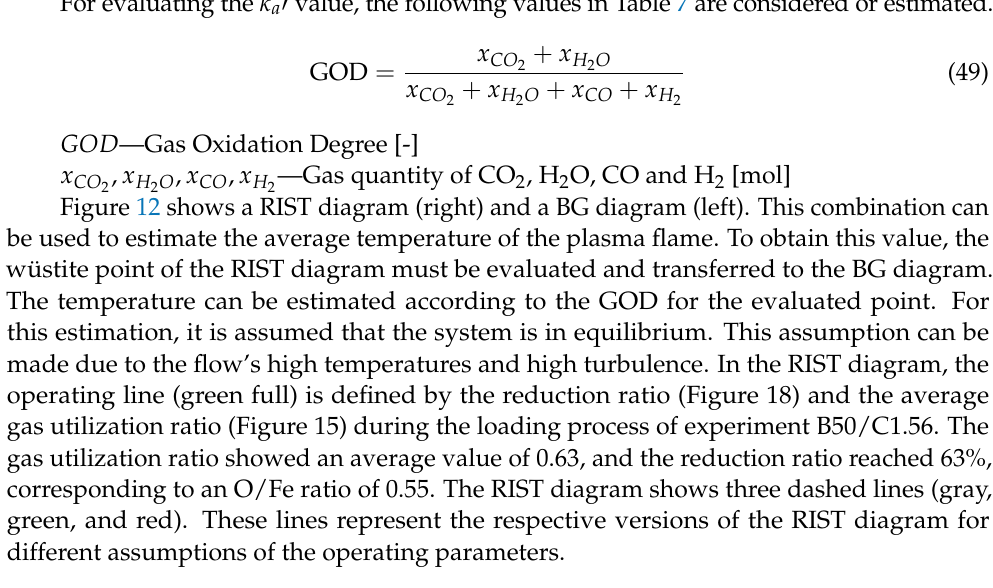
Table 7. Description of the methods for the evaluation of the parameters for the calculation of the k a